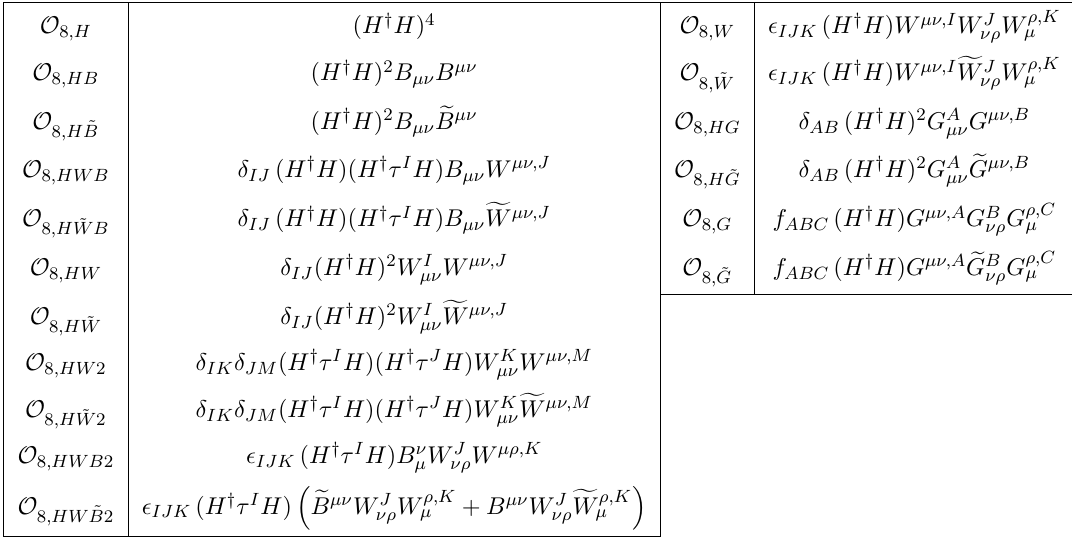
Table 4 . The 17 derivative-free operators after conversion to the standard X; e X notation for the (cid:12)eld-strength tensors and with H y in the (cid:22)2